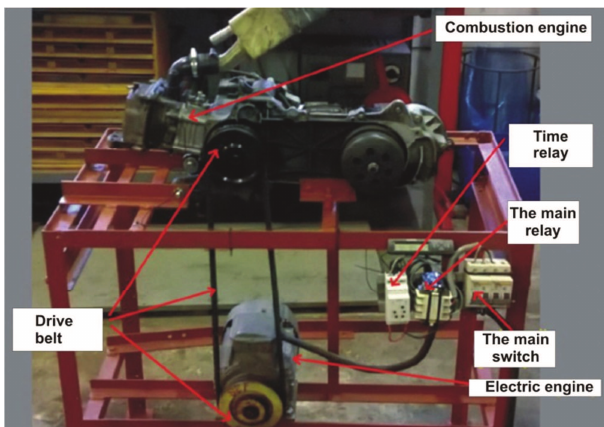
Fig. 5. The view of experimental stand with combustion engine and elec- tric steering system